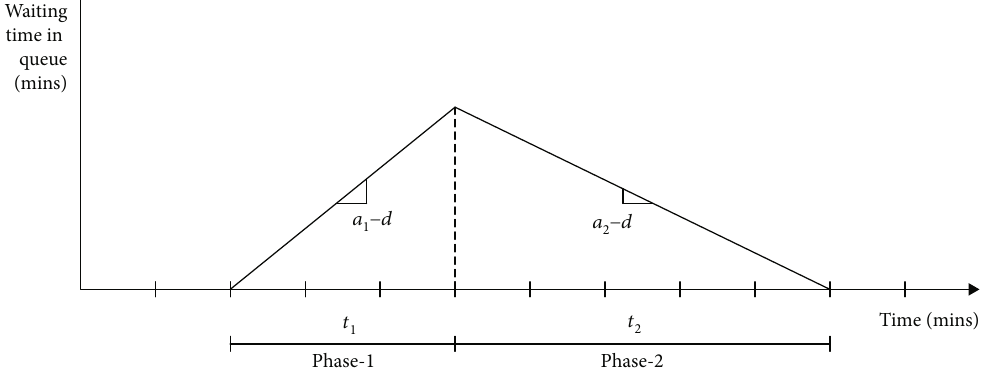
Figure 2: Waiting time of vehicles given the arrival time to bottleneck zone during the rush hour tra ffi